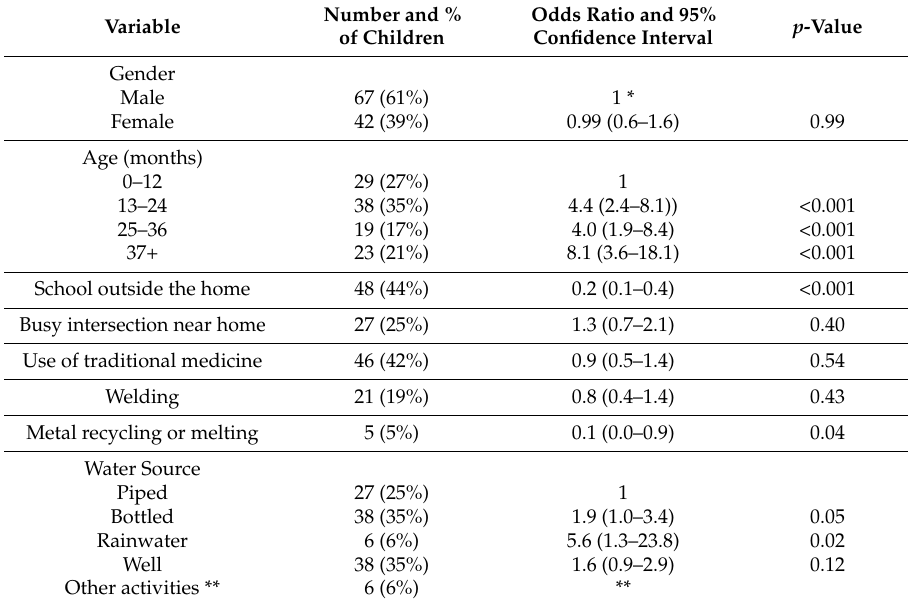
Table 4. Risk of high BLLs (>5 µ g/dL, n = 109), relative to child and family characteristics, by bivariate analysis.